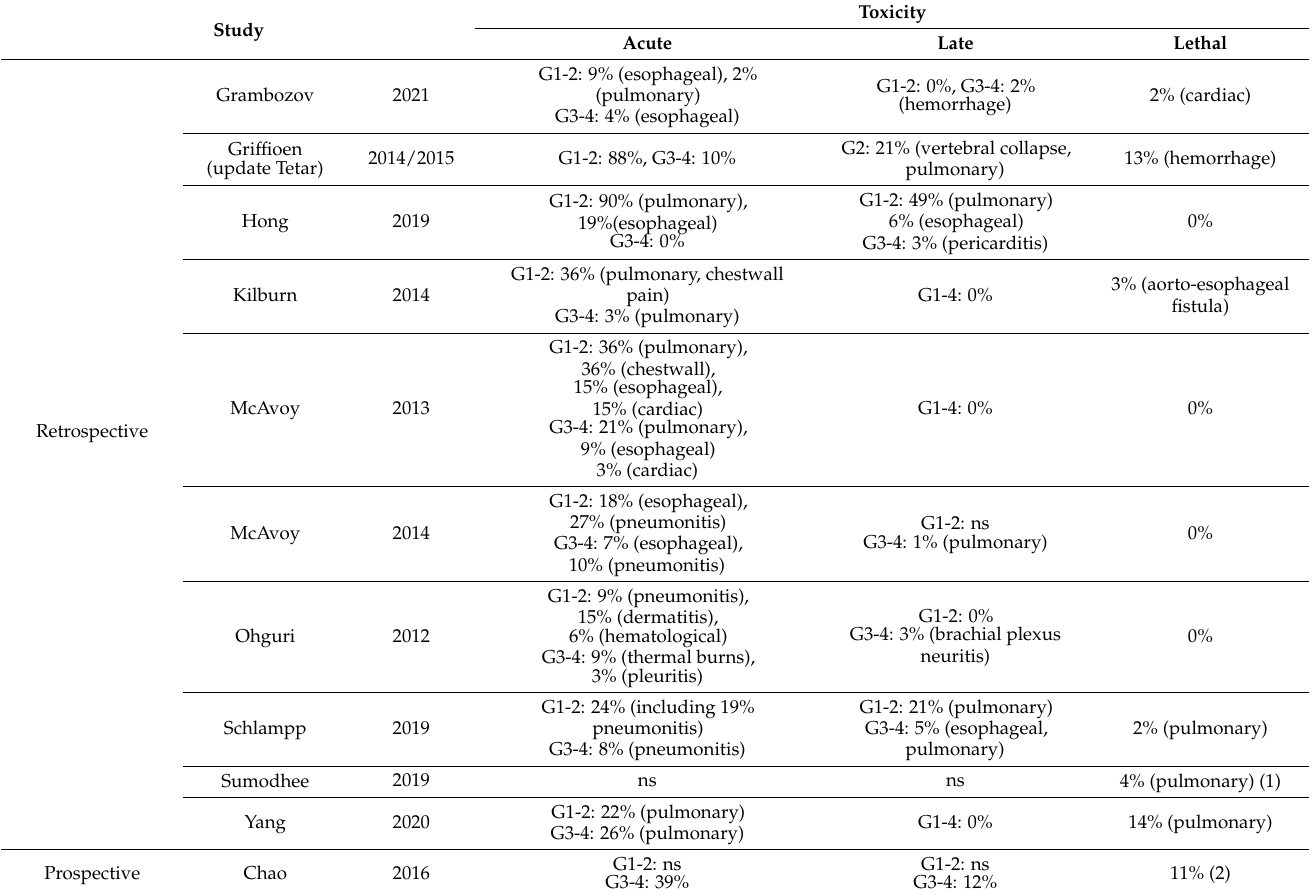
Table 4. Toxicity (ns = not